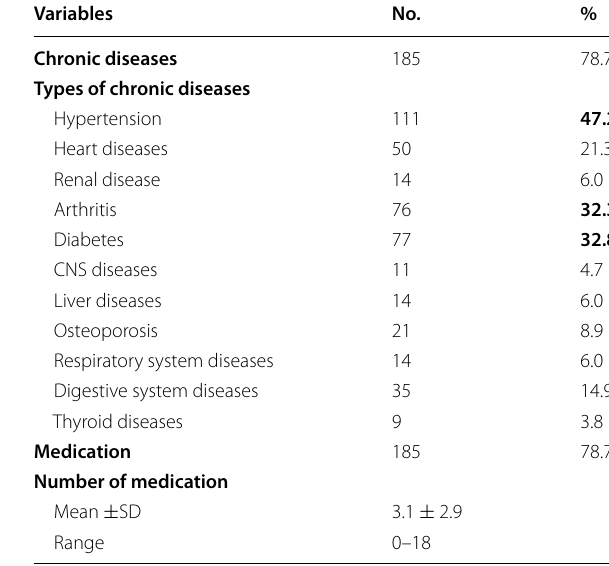
Table 2 Health status problems of studied elderly people ( n